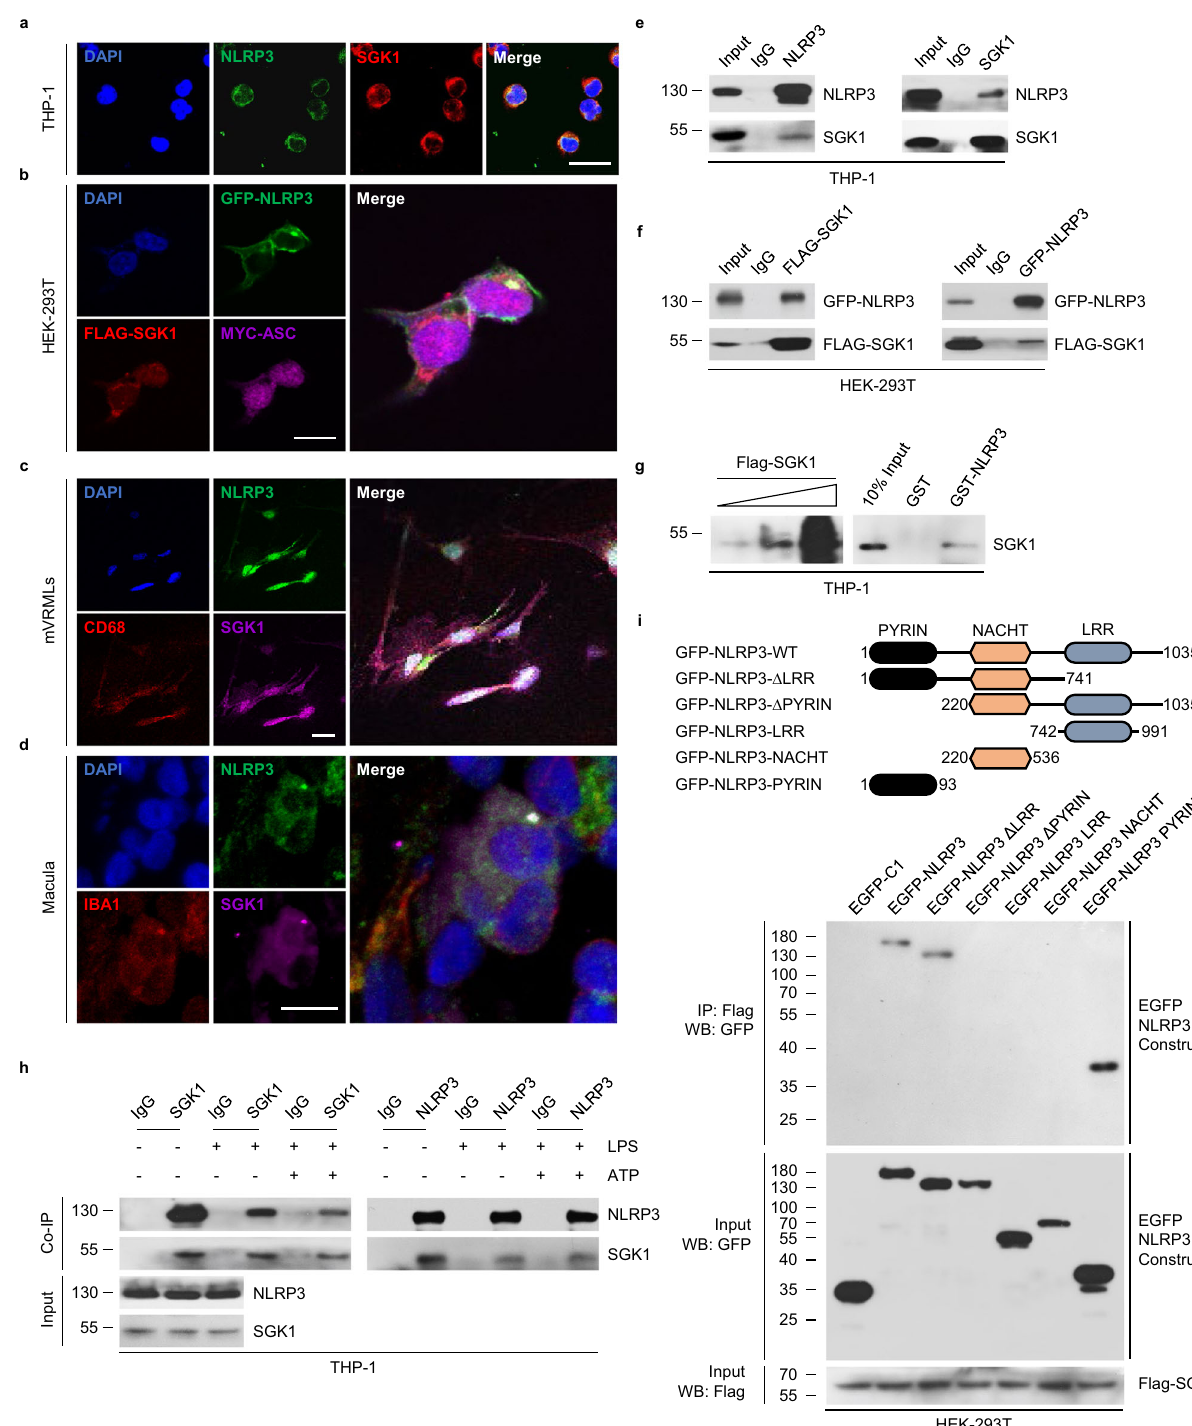
Fig. 3 | SGK1 co-localizes and interacts with NLRP3. a Immuno fl uorescence staining for DAPI (blue), NLRP3 (green), and SGK1 (red) in THP-1 cells that were stimulated with LPS (200ng/mL, 3h) and ATP (5mM, 30min), scale bar = 50 μ m. b Representative confocal images of HEK-293T cells transiently expressing GFP-NLRP3 (green), FLAG-SGK1 (red), MYC-ASC (magenta), and staining DAPI (blue), which were stimulated with LPS (200ng/mL, 3h) and ATP (5mM, 30min), scale bar = 50 μ m. c Immuno fl uorescence staining for DAPI (blue), NLRP3 (green), CD68 (red), and SGK1 (magenta) in primary mVRML cells of WT mice which were stimulated with LPS (200ng/mL, 3h) and ATP (5mM, 30 min), scale bar = 10 μ m. d Immuno fl uorescence staining for DAPI (blue), NLRP3 (green), IBA1 (red), and SGK1(magenta) in macula of MD patients, scale bar = 10 μ m. e Co-IP analysis of the interaction of NLRP3